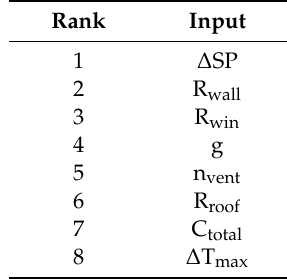
Table 4. Ranking representing the relative impact of the input on the annual space heating demand for the 272 buildings of the dataset (from the most impactful to the least